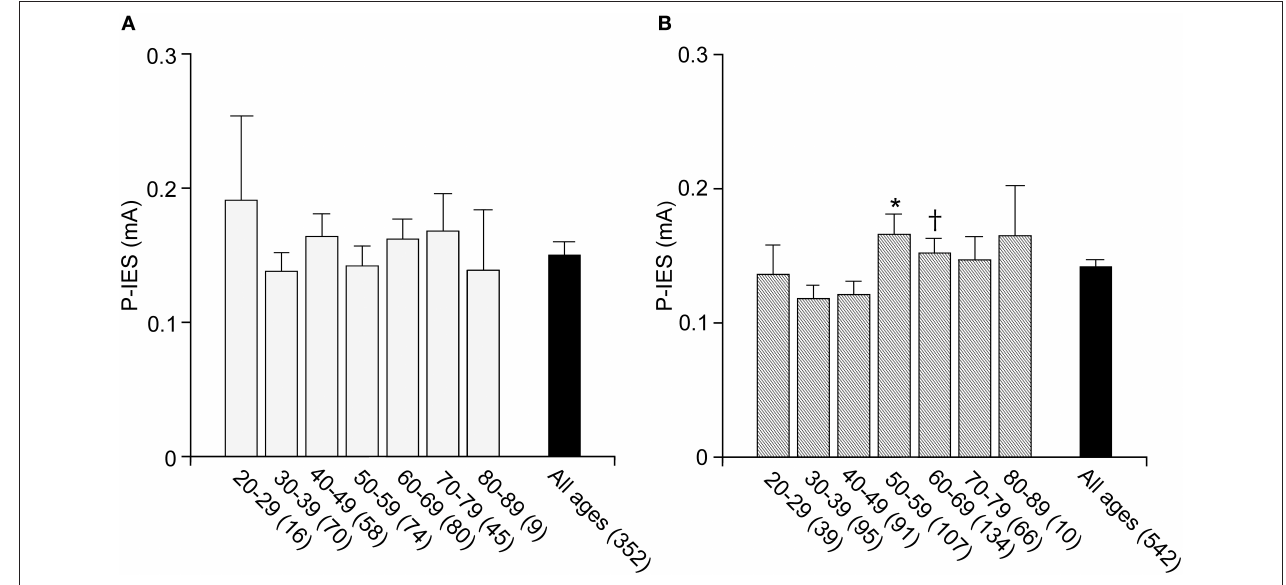
FIGURE 2 | P-IES in male and female. P-IES is consistent during each decade of life in men (A) . In contrast, women of 50–59 and 60–69 years old showed a significant increase in P-IES compared to 30–39 years old (B) . Mean ± SEM, * p < 0.01 vs. 30–39, p < 0.05 vs. 40–49, † p < 0.05 vs. 30–39.